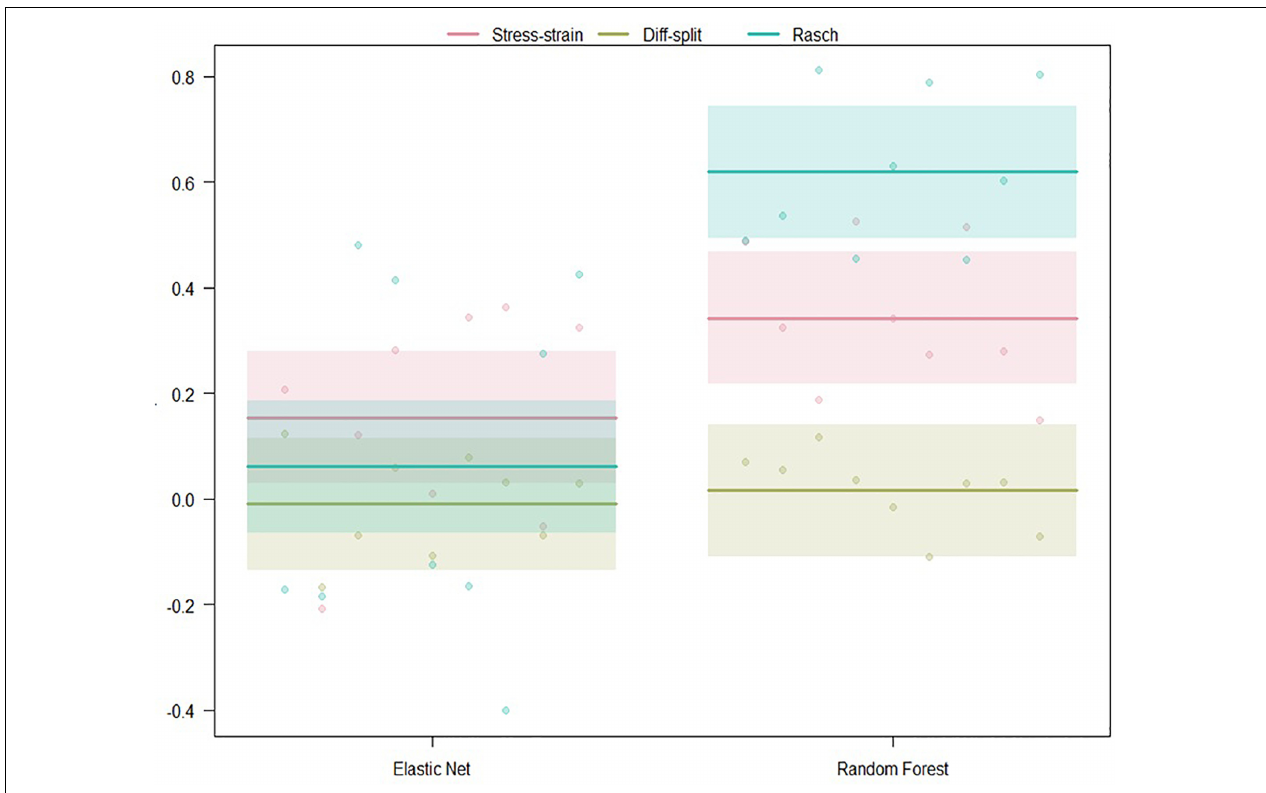
FIGURE 5 | Regression estimates for hold-out participants on the ISR task across labeling technique and machine learning algorithm. Points along the y -axis are GINI Index values for individual folds, lines are the regression estimate, and bars are the error of the estimate.